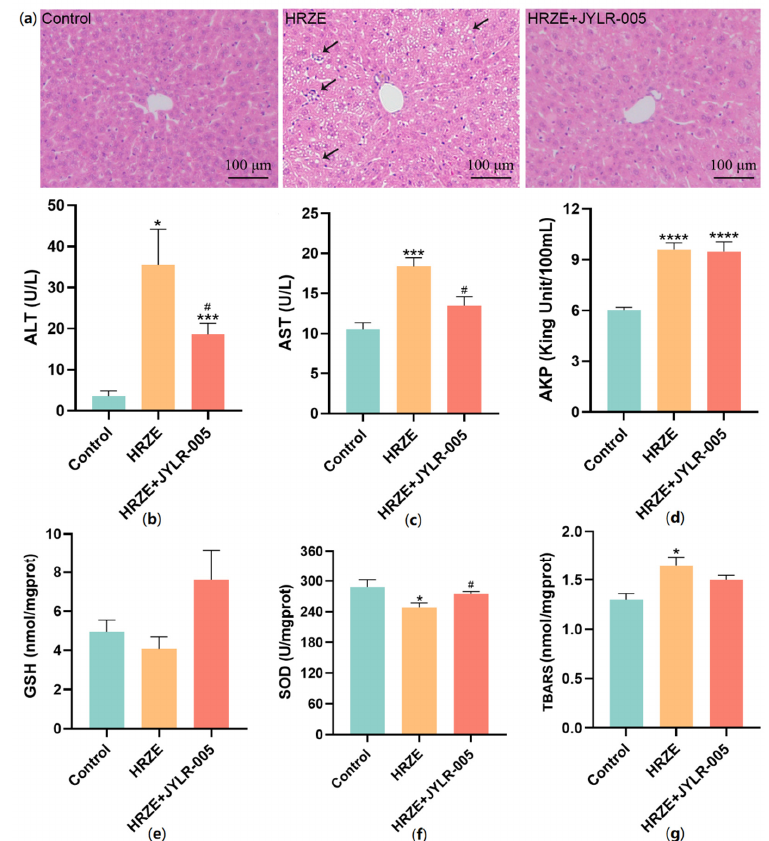
Figure 6. Lactobacillus rhamnosus JYLR-005 alleviates HRZE-induced liver injury. ( a ) Representative images of liver parenchyma H&E staining in each group, arrows mean inflammatory cell infiltration and lipid vacuoles; ( b )ALT, ( c )AST and ( d ) AKP levels of serum; ( e ) GSH, ( f ) SOD, and ( g ) TBARS (represents MDA level) levels of liver tissue homogenate in each group. The data are presented as the means ± SEM ( n = 6 per group). The HRZE + JYLR-005 group and the HRZE + MgIG group shared the control group and the HRZE group. Compared with the control group: * p < 0.05, *** p < 0.001, and **** p < 0.0001. Compared with the HRZE group: # p < 0.05. 2.6. Supplementation with Lactobacillus Rhamnosus JYLR-005 Decreases HRZE-Induced Intestinal Permeability and Inhibits HRZE-Induced LPS/TLRs/NF- κ B Pathway Activation Compared with the HRZE group, serum LPS and FD4 concentrations in the HRZE + JYLR-005 group were significantly decreased ( p < 0.05, Figure 7a,b). In addition, sup- plementation with Lactobacillus rhamnosus JYLR-005 significantly reduced HRZE-induced elevation of inflammatory factors TNF- α , IL-1 β , and IL-6 mRNA levels ( p < 0.05, Figure 7c–e). In comparison with the HRZE group, supplementation with Lactobacillus rhamnosus JYLR-005 significantly up-regulated the mRNA expression levels of TLR2, TLR4, and NF- κ B ( p < 0.05, Figure 7g,h).